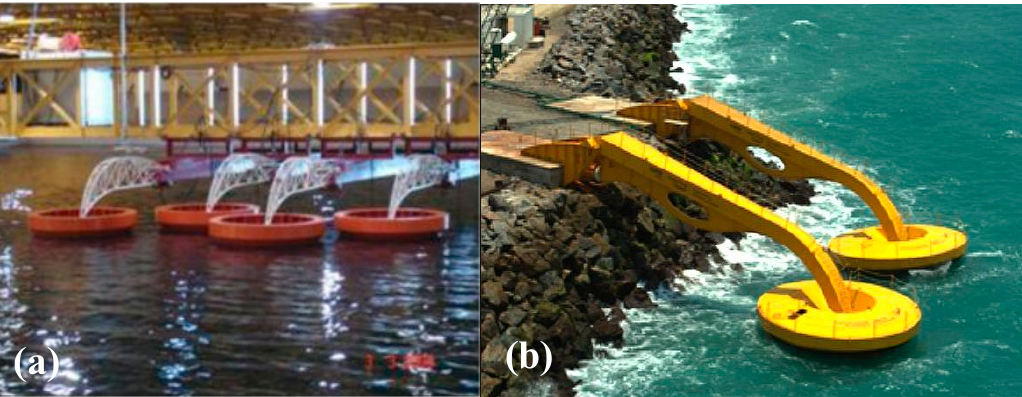
Figure 19. COPPE hyperbaric wave converter: ( a ) medium-scale model with a ratio of 1:10 at LabOceano [187]: ( b ) installed full-scale prototype.